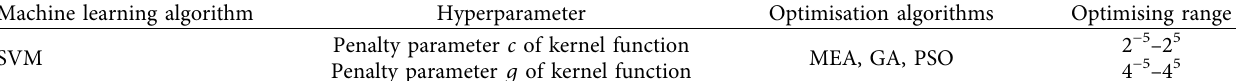
Table 2: The optimised hyperparameters in the machine learning models.